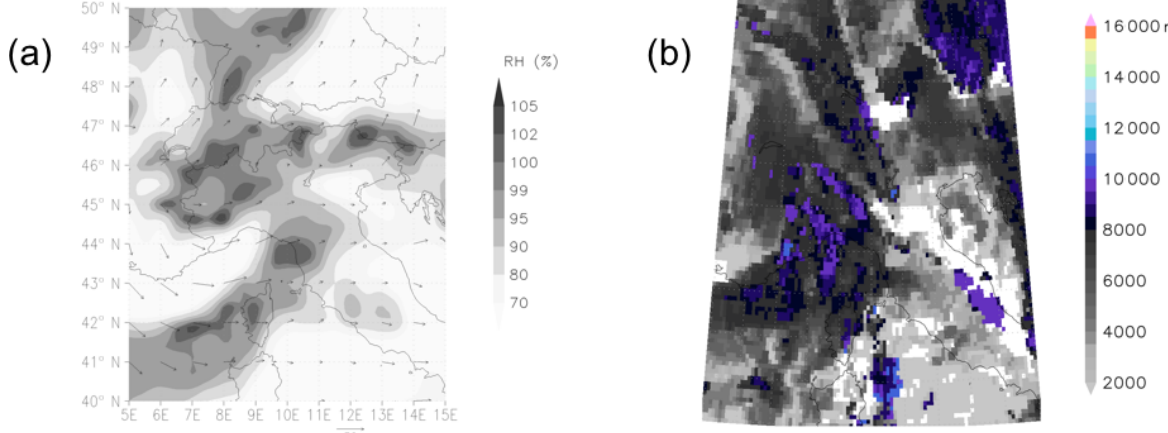
Figure 21. Panel (a) : relative humidity (shaded contours) at 700hPa and mean storm motion (vectors) from GFS analyses on 21 November 2013 at 12:00UTC. Panel (b) : cloud top height from MSG data on 21 November 2013 at